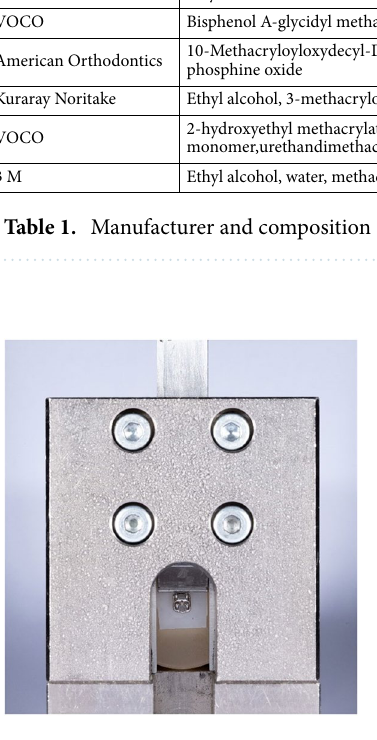
Figure 2. Experimental setup for the SBS measurements. Zirconia substrate with the metal bracket is placed in a special test apparatus. The force was applied in occlusal-gingival direction and the maximum force was